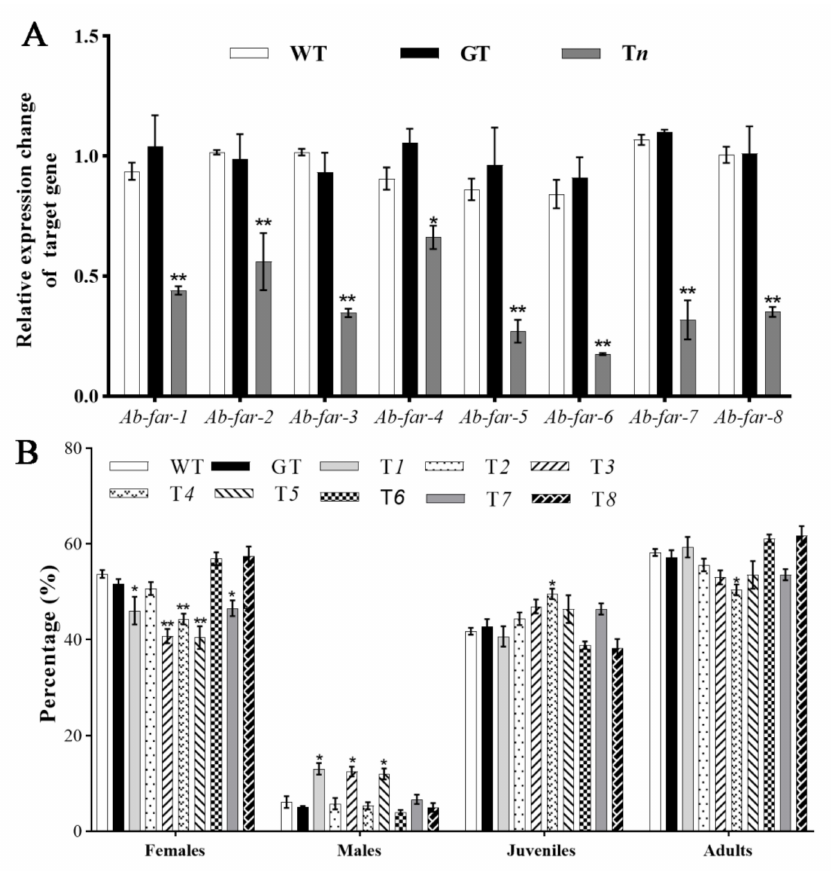
Figure 3. Ab-far-n expression and proportion of females, males, juveniles and adults of Aphelenchoides besseyi fed Ab-far-n hpRNA transgenic Botrytis cinerea . ( A ) Ab-far-n expression levels. ( B ) Proportion of females, males, juveniles and adults of Aphelenchoides besseyi . WT, nematodes cultured on wild- type B. cinerea ; GT, nematodes cultured on eGFP hpRNA transgenic B. cinerea ; T 1 -T 8 , nematodes cultured on Ab-far-1 to Ab-far-8 hpRNA transgenic B. cinerea . To determine silencing efficiency of gene, the gene expression from WT was normalized as 1 and fold change was calculated using the 2 - ∆∆ Ct method to determine change in expression of the genes of interest. Values of figure A are means ± standard error, n = 9. Values of figure B are means ± standard error, n = 10. Asterisks indicate values that are significantly different from the WT treatment (* p < 0.05, ** p < 0.01; t